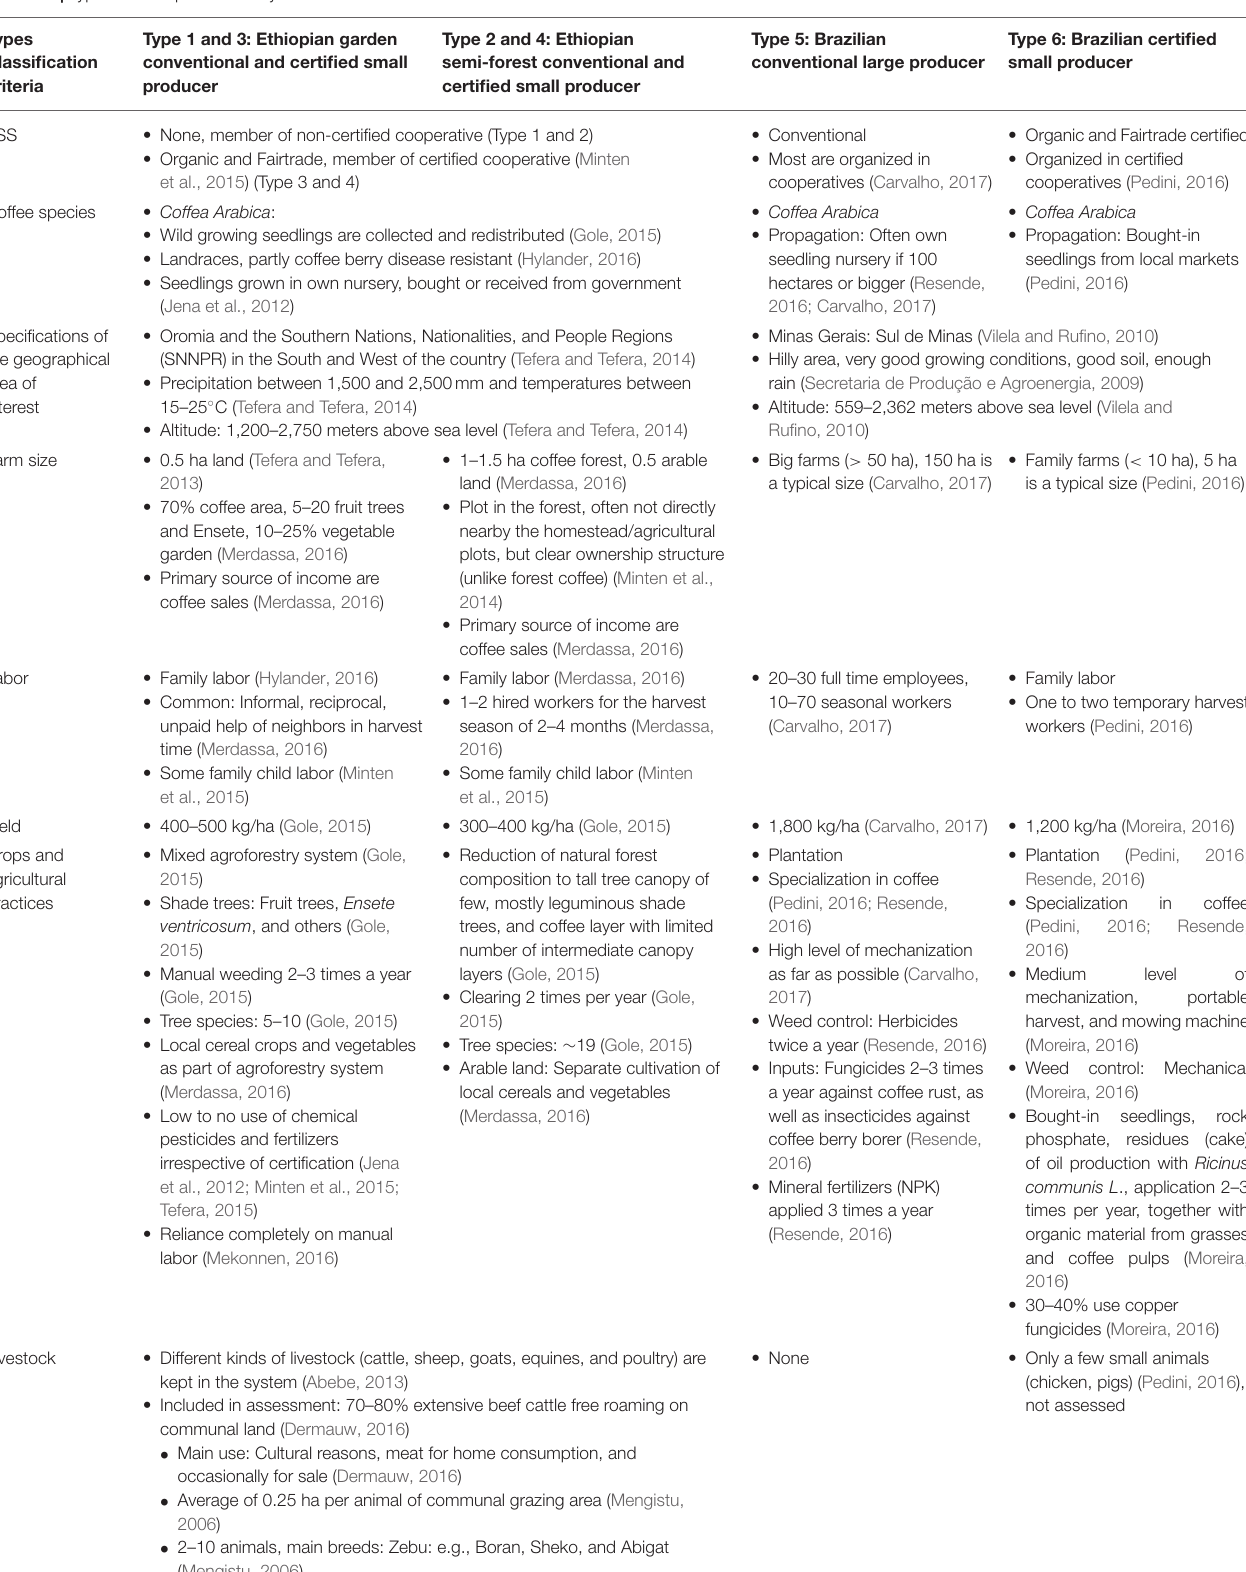
TABLE 2 | Typical coffee production systems. Types Classification